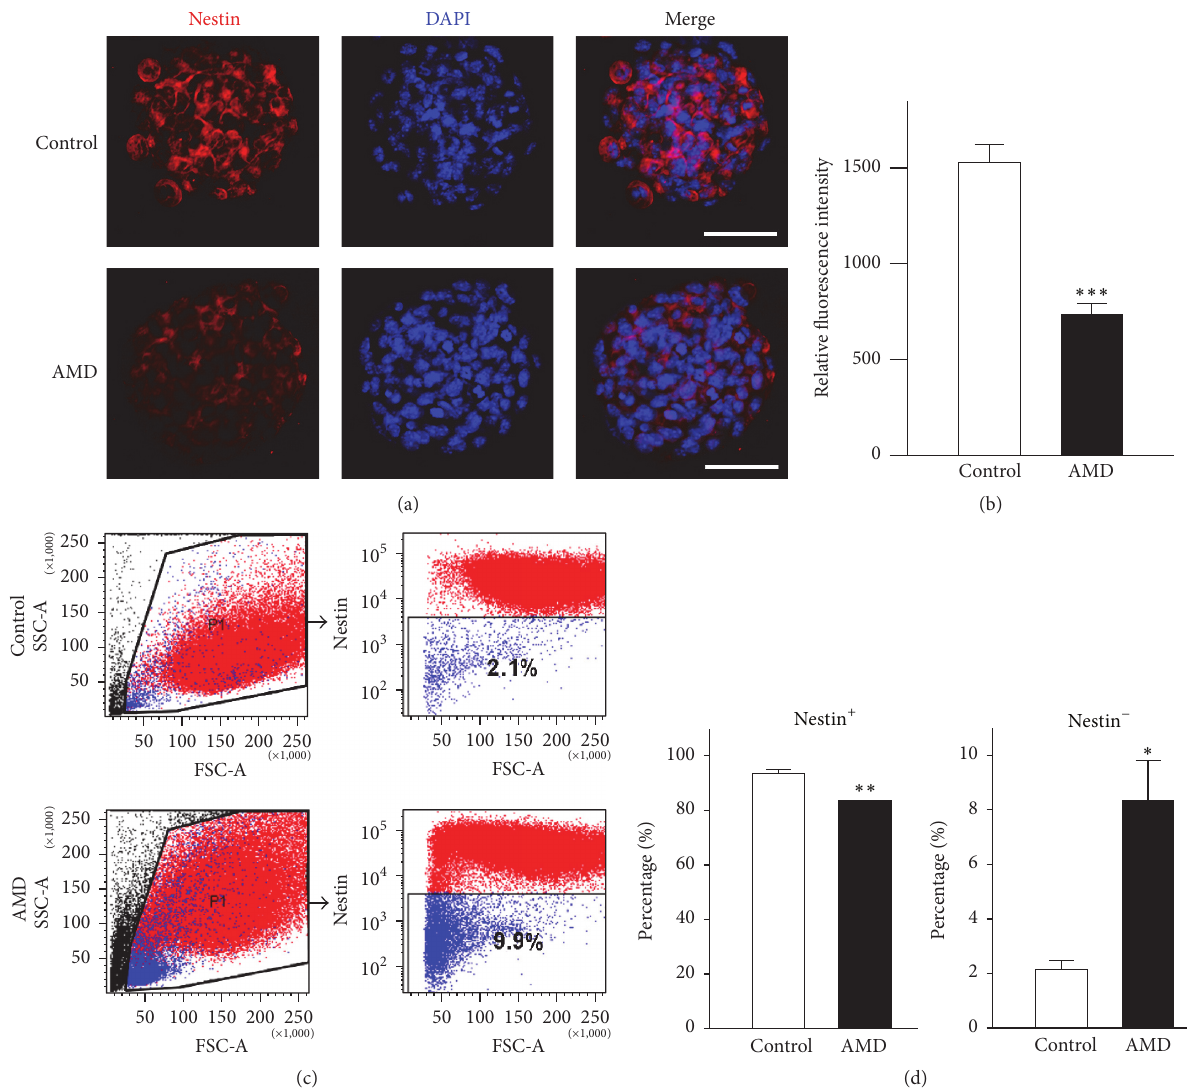
Figure 3: Blockage of CXCR4 signaling transduction impaired the nestin expression in primary neurospheres. (a) Representative images showing nestin (red) in PBS- and AMD-treated neurospheres. DAPI (blue) stained nuclei are used. (b) Quantification of nestin intensity in control or AMD group neurospheres. Data represent the mean ± SEM, control, 𝑛 = 10 ; AMD, 𝑛 = 11 , ∗∗∗ 𝑝 < 0.001 . Scale bar, 50 𝜇 m. (c) (d) Analysis of nestin − cells in neurospheres after PBS or AMD treatment. Single cell suspensions dissociated from neurospheres were stained and analyzed by flow cytometry. The flow quantification results show a dramatic increase in the percentage of nestin − cells in AMD-treated group. Data are given as mean ± SEM, 𝑛 = 3 , ∗ 𝑝 < 0.05 , ∗∗ 𝑝 < 0.01 , Student’s 𝑡